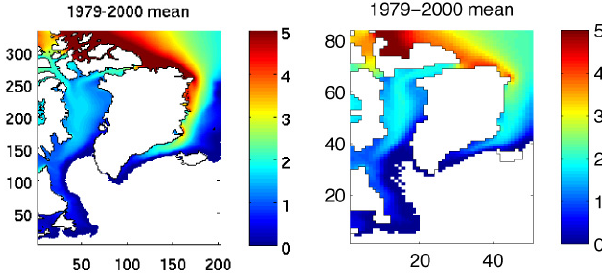
Fig. 1. Surface current speed (ms − 1 ) averged over 1958–2001 in control experiments with NEMO at resolutions of 0.25 ◦ and 1 ◦ (left and right panels respectively).